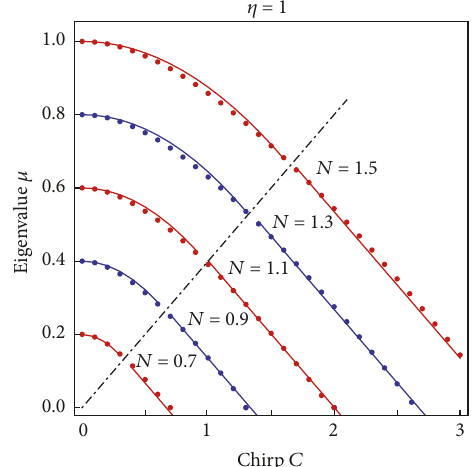
Figure 4: Soliton energy eigenvalues when the chirp is varied. Data shown as dots for 𝜂 = 1 and 𝑁 = 0.7 (lowest trace); 0.9 ; 1.1 ; 1.3 ; and 1.5 (top trace). Lines: fits with (17) and